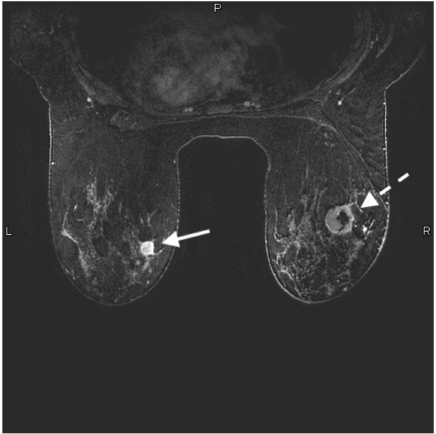
Figure 1. 28-year-old woman with a known BRCA 2 genetic mutation presented for her baseline annual high-risk screening MRI. Axial contrast-enhanced T1-weighted fat-suppressed image shows a 1.4 × 1.3 × 1.2 cm rim enhancing mass in the upper inner left breast (solid white arrow). This was a biopsy-proven grade 3 invasive ductal carcinoma. There is also a 3.1 × 3.6 × 2.1 cm rim enhancing mass with central necrosis in the upper outer right breast (white dashed arrow). This was also biopsy-proven grade 3 invasive ductal